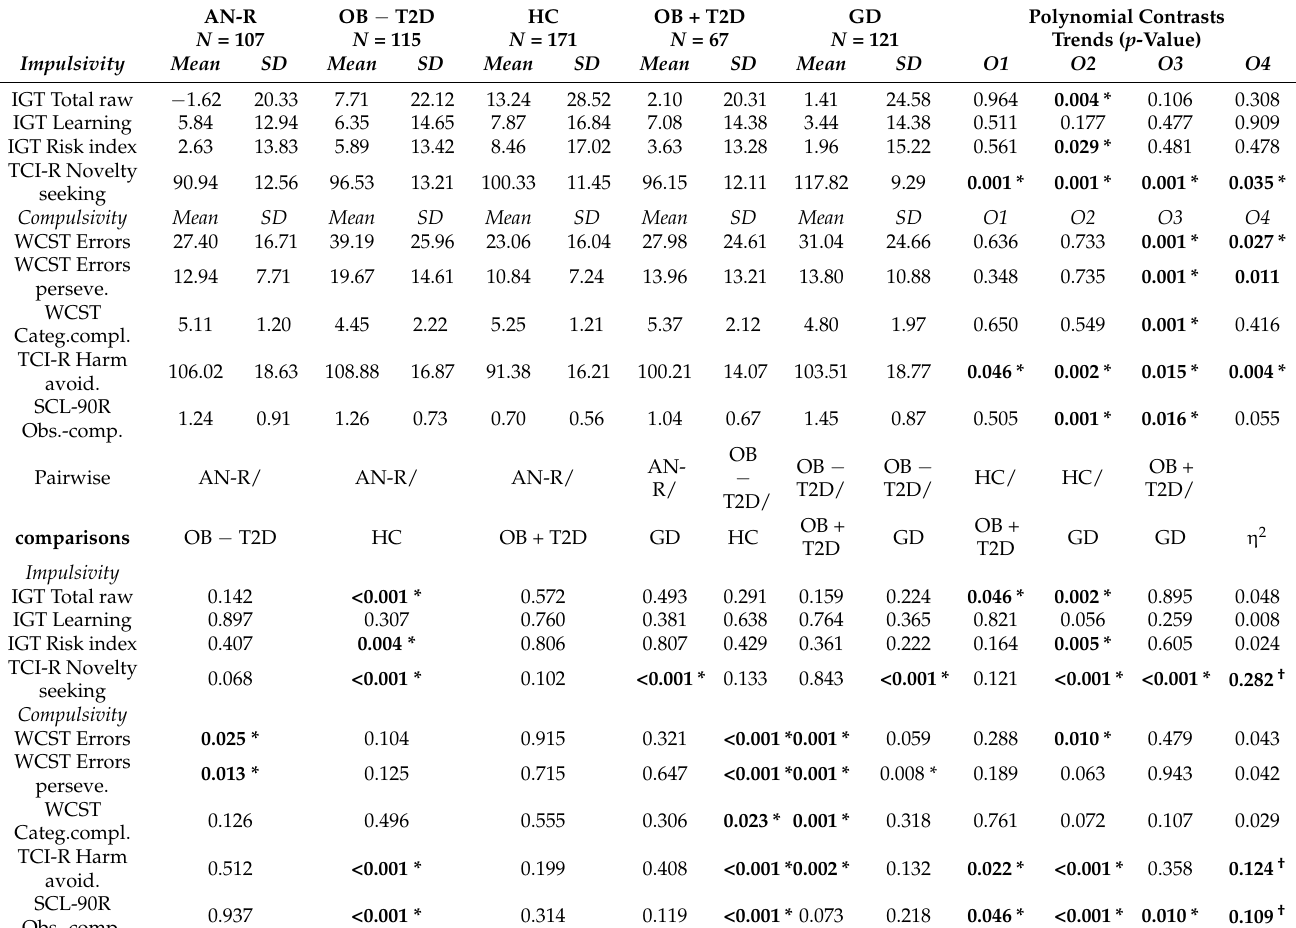
Table 2. Comparison between the groups in impulsivity and compulsivity measurements. ANCOVA adjusted by sex, age, education and BMI.